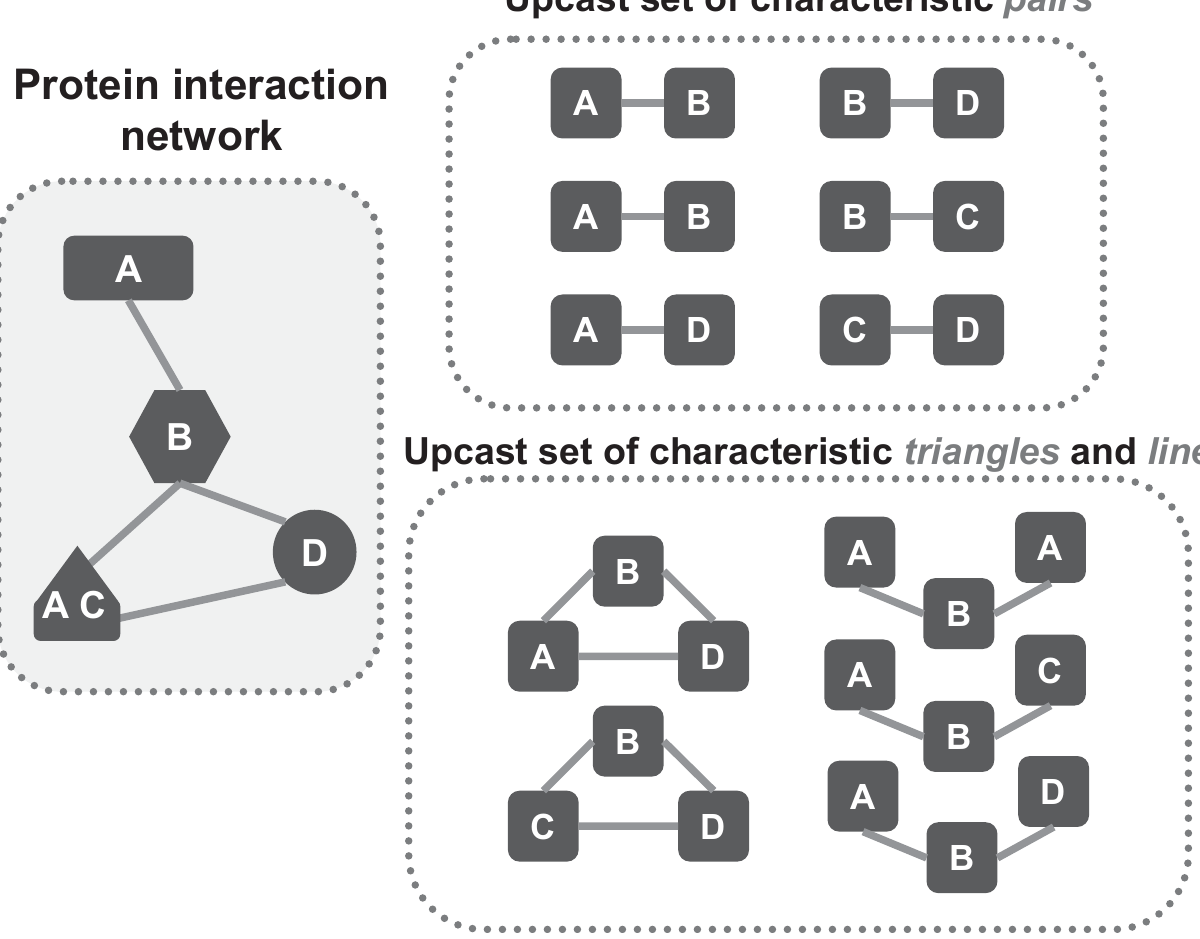
Figure 1. Upcast Sets of Characteristic Pairs and Triplets. In this example, we consider only a single characteristic (e.g., protein function), so that the characteristic vector for a protein is a 1-vector. There are three single-category proteins and one two-category protein in the protein interaction network (left), which result in an upcast set of six characteristic pairs { A – B , A – B , A – D , B – D , B – C , C – D }. Alternatively, the upcast set of triplets includes two triangles and three lines.